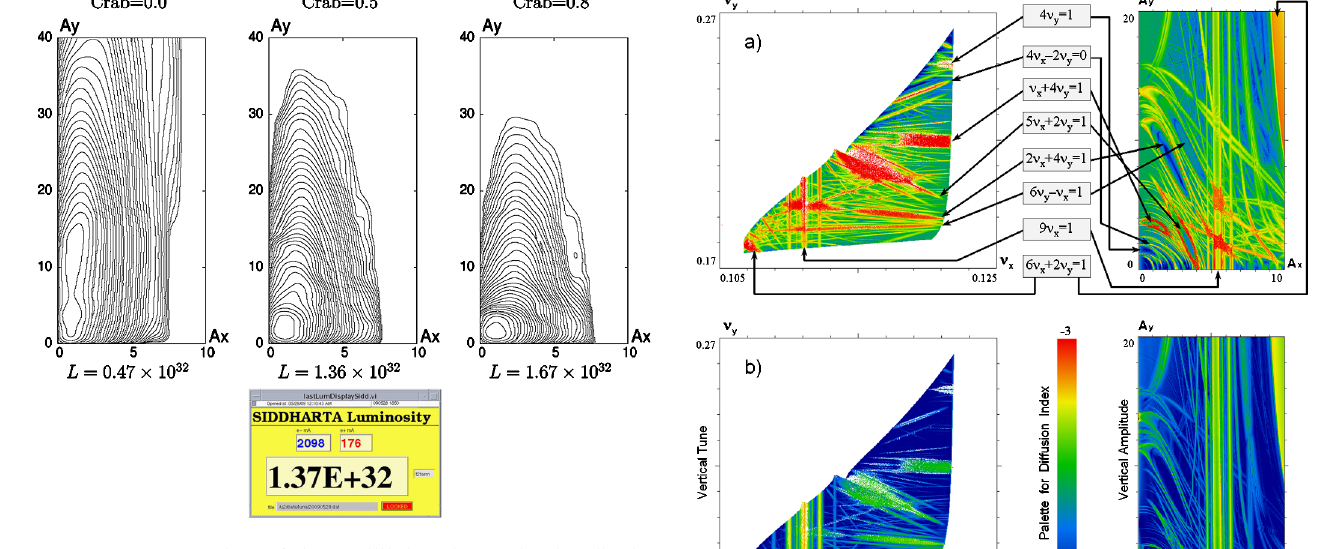
(b).FIG. 4. Contour plots of the equilibrium beam density distri- bution in the plane of normalized betatron amplitudes and luminosity (numbers at the bottom, in cm (cid:4) 2 c (cid:4) 1 ) versus the crab value. The luminosity obtained experimentally on DA(cid:1)NE with crab ¼ 0 : 5 is shown in the yellow